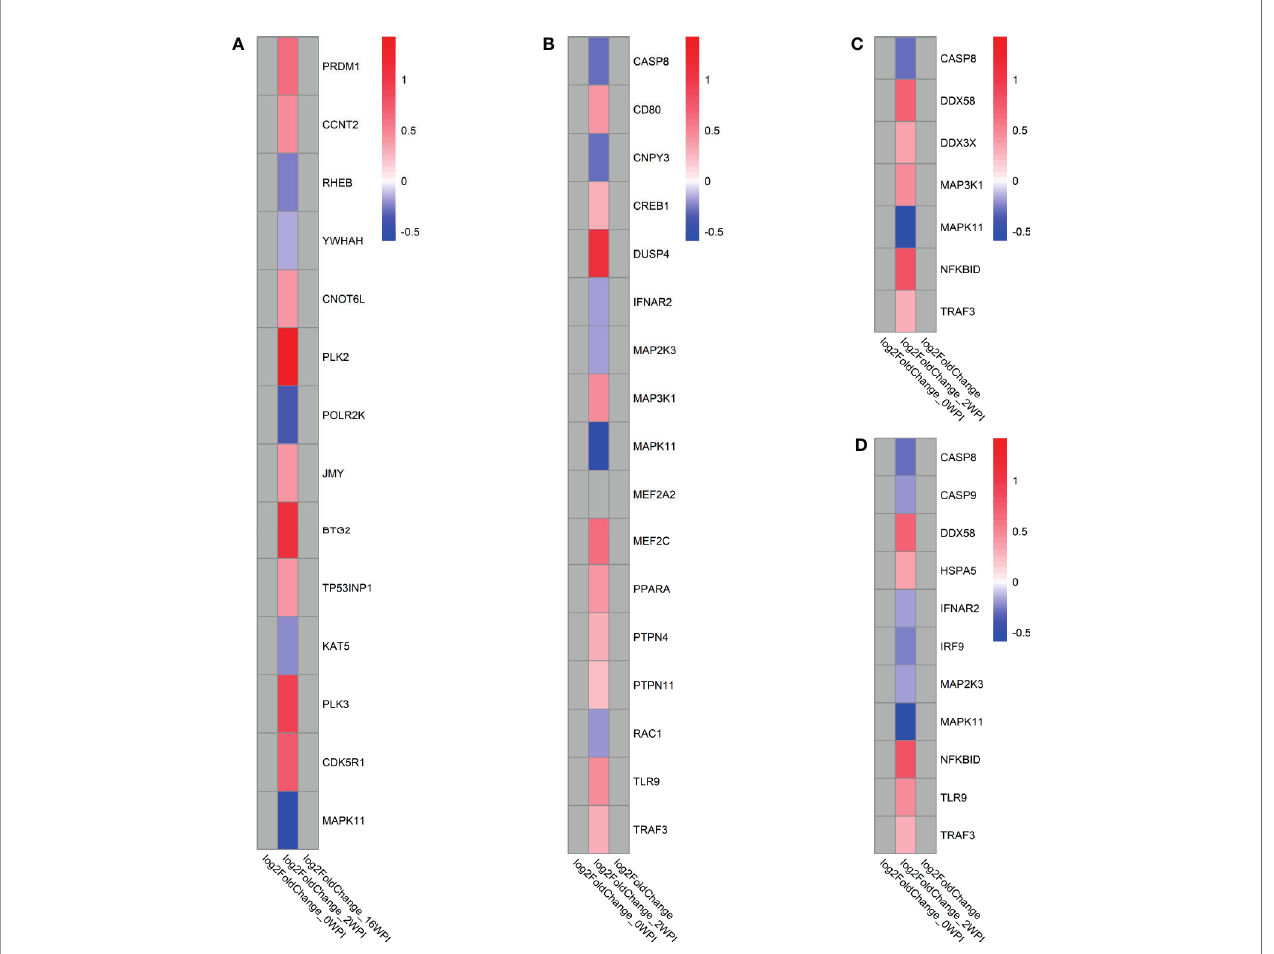
FIGURE 5 | Log 2 fold change of genes involved in selected KEGG, REACTOME and IPA pathways in response to F. hepatica (infected vs control analysis) at each time point. (A) Transcriptional Regulation by TP53 (REACTOME), (B) Toll-like receptor signalling (REACTOME, KEGG, IPA), (C) RIG-I-like receptor signalling pathway (KEGG,IPA), (D) The role of PKR in interferon induction and antiviral response (IPA). Grey tiles show genes that were not signi fi cantly DE. If pathways were found in multiple databases, gene lists were derived as a consensus of all genes in the pathway found in all